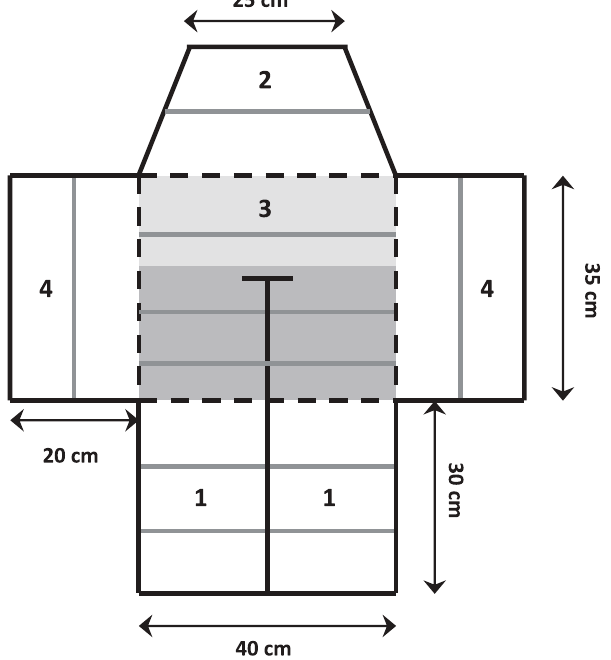
Figure 1. Top view of the binary mate-choice apparatus with: the female compartment (1), the end compartment (2), the choice compartment (3), and the observation compartments (4). The grey lines represent the perches while the black lines correspond to the partitions that were either opaque (full lines) or clear (dashed lines). The choice compartment (3) was divided into the neutral zone (pale grey) and the choice zone (dark grey).